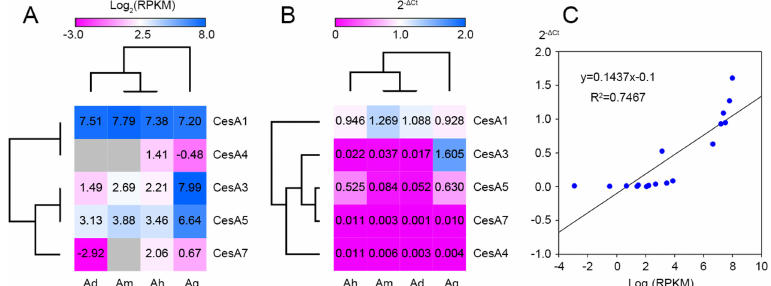
Figure 5. Expression analysis of Agave CesA genes by RNA-seq ( A ), RT-qPCR ( B ) and correlation analysis between them ( C ). Blanked squares represent no